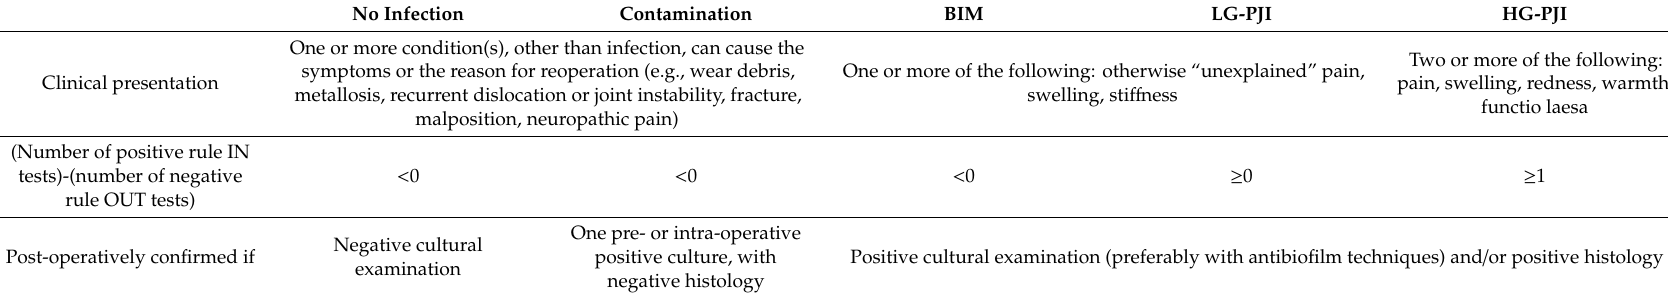
Table 2. World Association against Infection in Orthopaedics and Trauma (WAIOT) proposed definition of peri-prosthetic joint infection (PJI). Pre- and intra-operative tests, classified according to their sensitivity and specificity and hence their ability to exclude (“rule OUT”) or to confirm (“rule IN”) a PJI. In parenthesis, the reference cut-o ff value considered here (modified from